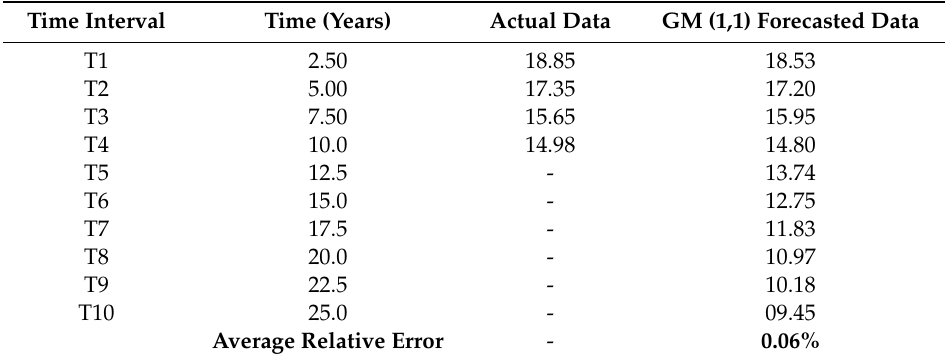
Table 1. Grey forecasting values of detonators using GM